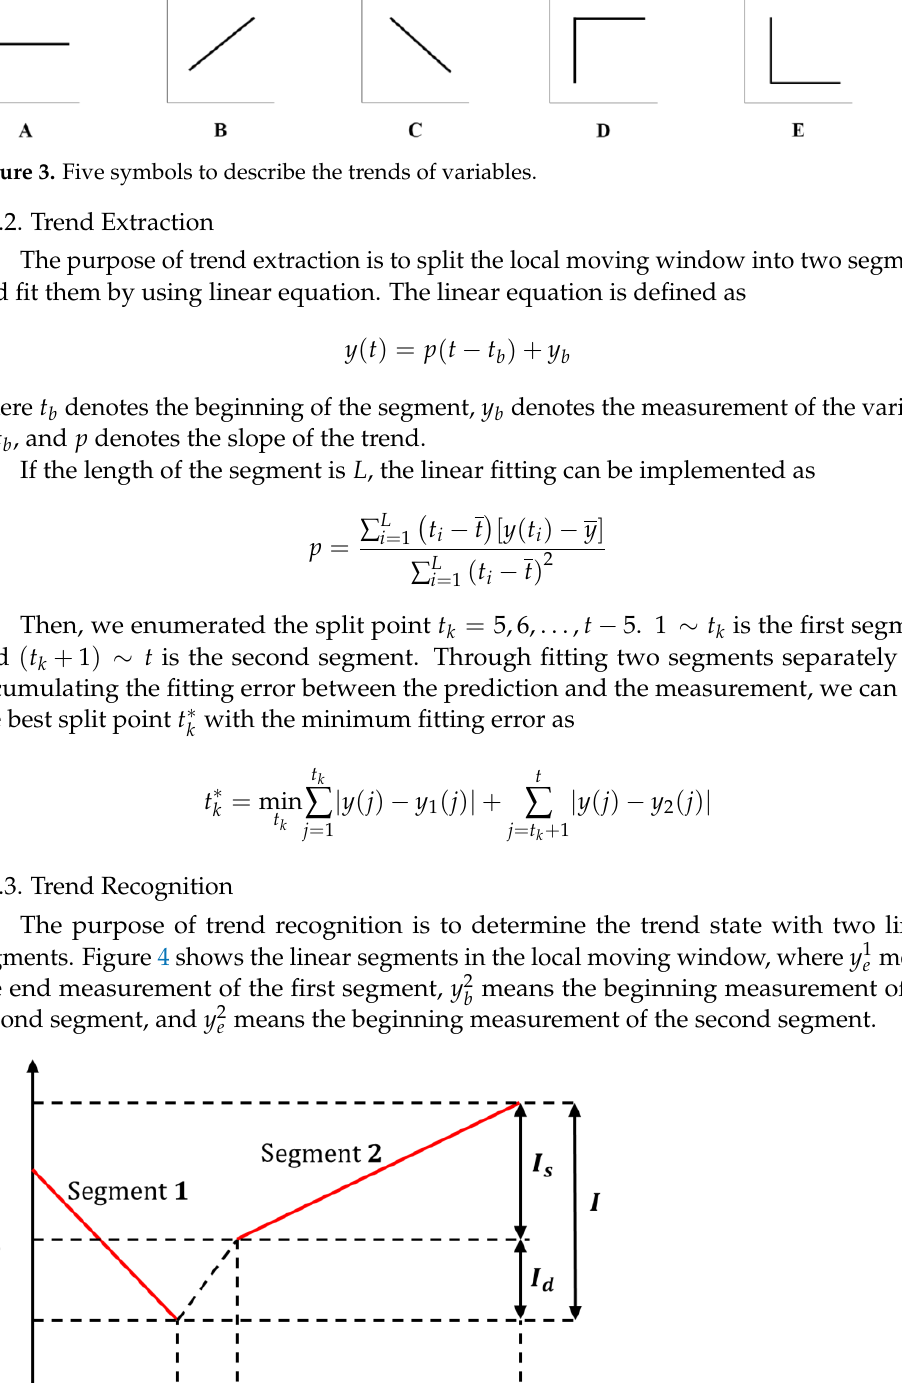
Figure 5. The rule of the trend recognition. 3.3. Five-State Bayesian Network The Bayesian network is a model that regards variables as nodes, uses the causality between variables as edges, and calculates the conditional probabilities to measure the information flow relationship of variables [46,50]. The definition of the Bayesian network is as 𝐺 = (𝑉, 𝐸, 𝜓) (16) where 𝑉 denotes the nodes, 𝐸 denotes the edges between the nodes, and 𝜓 denotes the states of the nodes. The typical Bayesian network used for industrial process monitoring has two states, 𝜓 ∈ {normal, abnormal} . In practical industrial processes, only using two states cannot describe the trends of variables and the positive/negative effects between variables. For example, with a positive effect A → B, B rises when A rises, and B falls when A falls; with a negative effect C → D, D rises when C falls, and D falls when C rises. Con- sidering the trend states extracted by TSQTA, we developed an FSBN method. Because